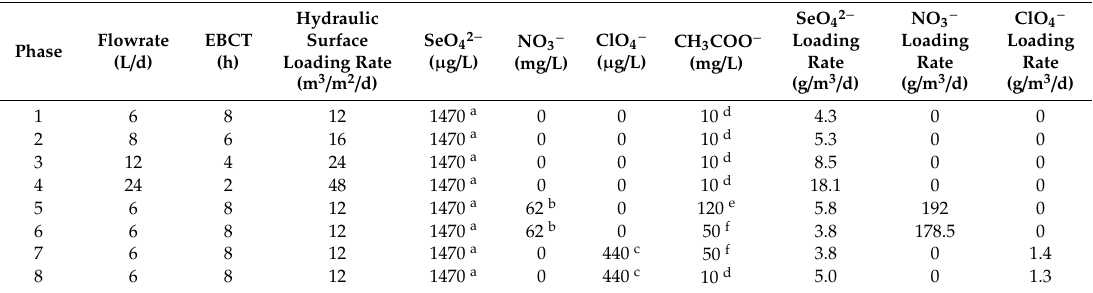
Table 1. Experimental design to test the e ff ects of various oxyanions and carbon source conditions on biological selenate reduction. EBCT, empty bed contact